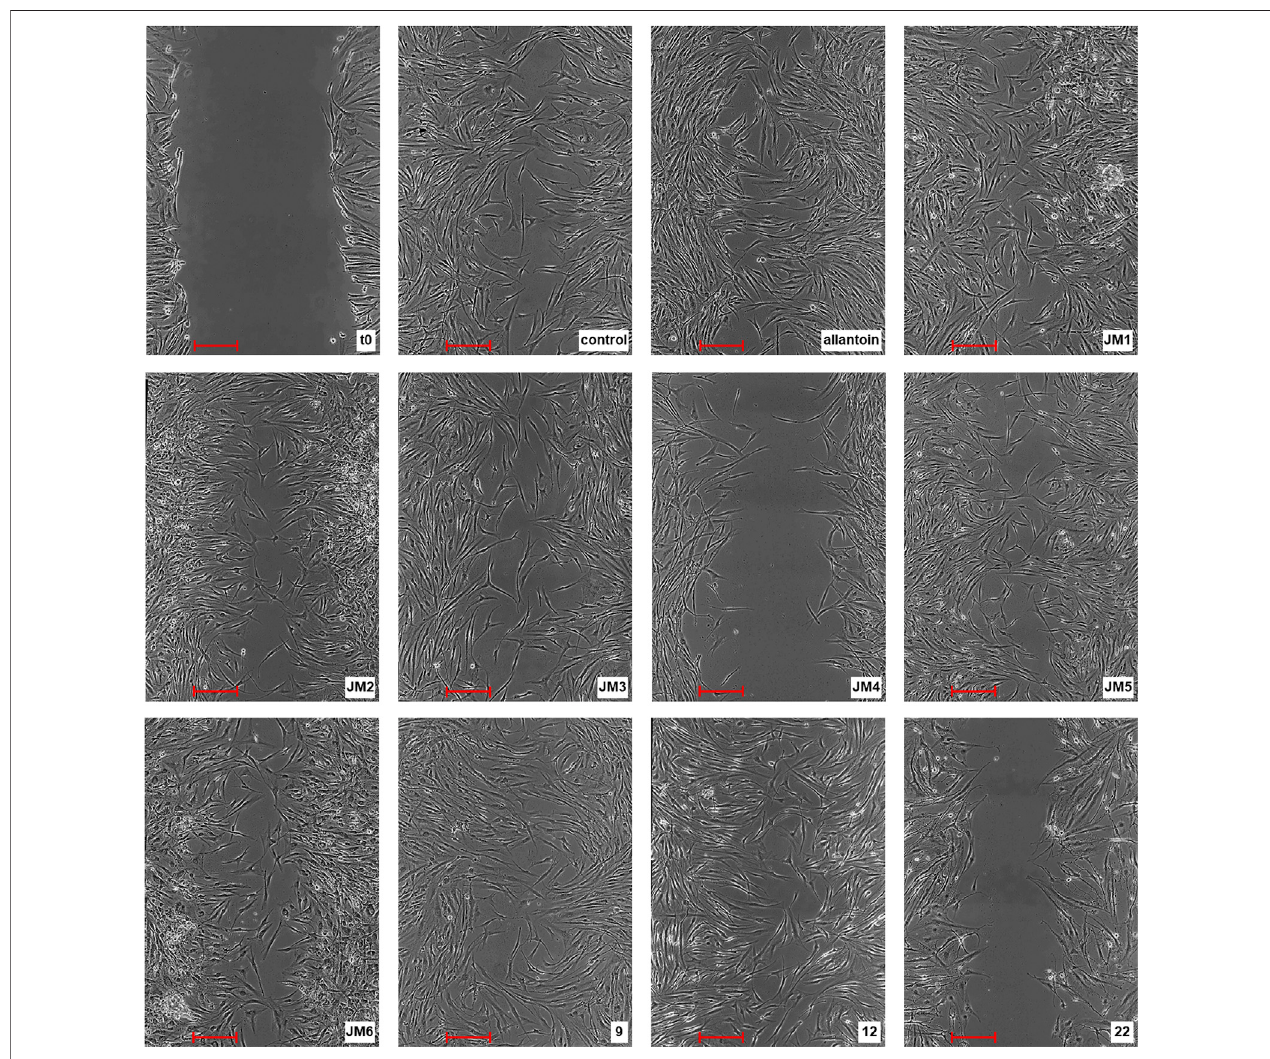
FIGURE 1 | Representative image of the in vitro scratch migration assay in fi broblast cells immediately after the wounding (t0), untreated (control) or treated with allantoin (50 μ g/mL), extracts JM1 – JM6 (50 μ g/mL), or compounds 9 , 12 (25 μ g/mL) or 22 (10 μ g/mL) after 24 h incubation evaluated by phase contrast microscopy (magni fi cation × 100) (scale bar 250